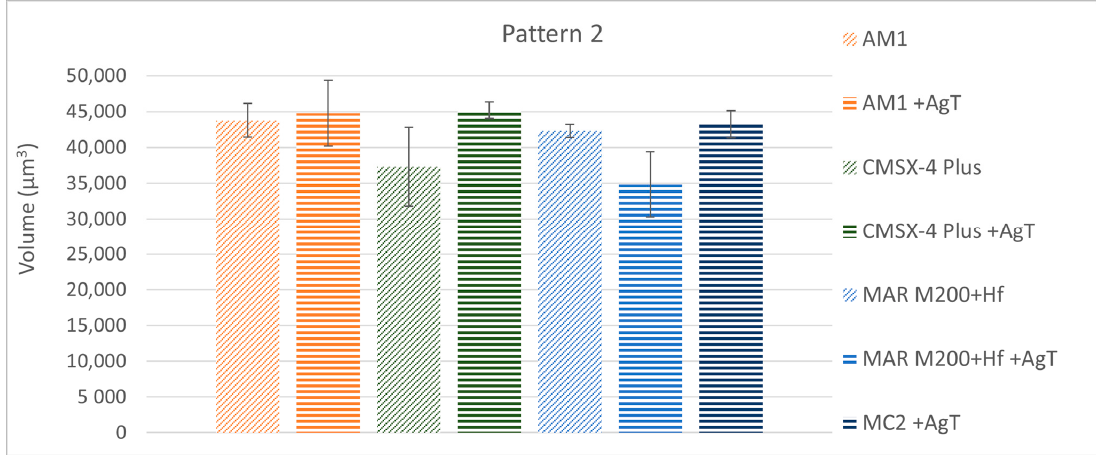
Figure 10. Thermally affected volumes of textured pattern 2 on different Ni ‐ based single crystal superalloys.